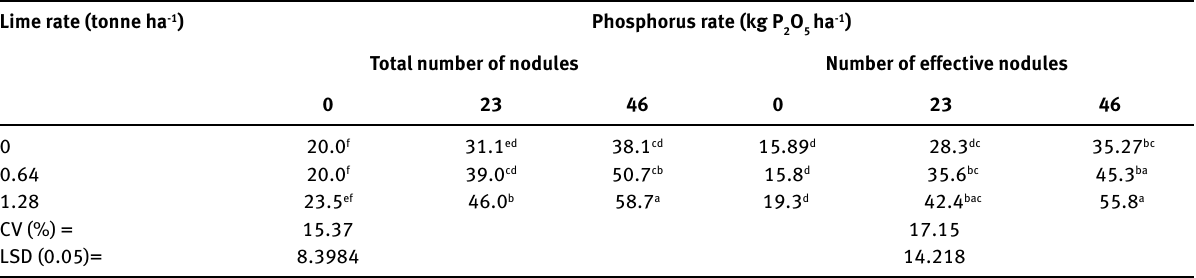
Table 5. Interaction effect of lime and phosphorus on total number of nodules and number of effective nodules per plant during long rainy